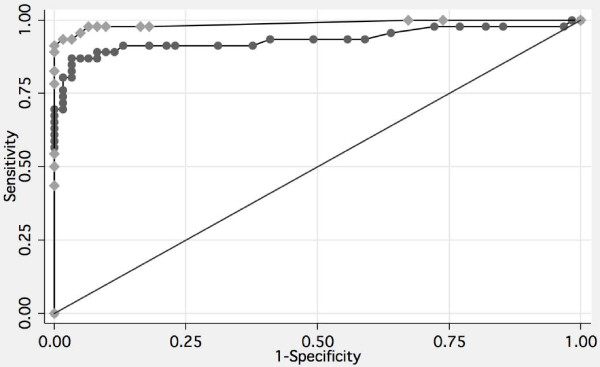
ROC curve comparison. ROC curves are displayed for the multi-analyte algorithm (midkine, AGR2 and CA125) and CA125 alone. The AUC (± SEM) for the multi-analyte panel (black diamond) (0.988 ± 0.010) was significantly greater than that of CA125 alone (black circle) (0.934 ± 0.030, p = 0.035).